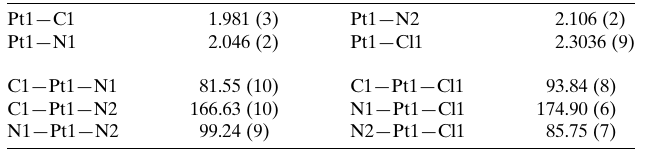
Table 1 Selected geometric parameters (A˚ , (cid:2) ).